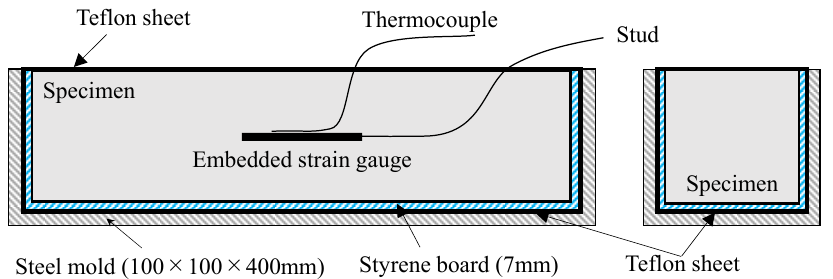
Figure 2. Overview of autogeneous expansion and shrinkage [27].